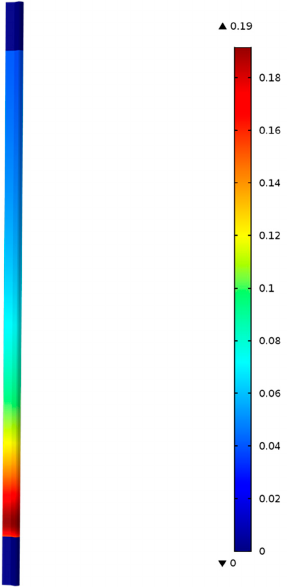
Molecules 2017 , 22 , 1579